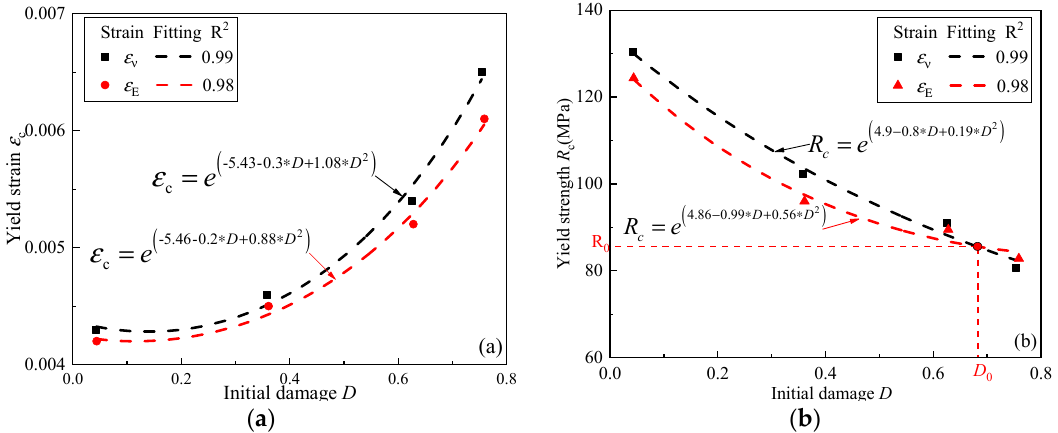
Figure 13. Comparison of the two initial damage methods. ( a ) ε c - D ; ( b ) R c - D. Due to the rock’s inelastic material, rock strain cannot fully recover after loading and unloading. Furthermore, the plastic strain and initial damage accumulate accordingly. Hence, the degree of initial damage is larger than that obtained by the longitudinal wave velocity method, D E > D v . The compressive strength and destructive strain of D E and D v are shown in Table 9. The compressive strength varies nonlinearly with respect to the initial damage, and an exponential relationship is applied and expressed as: